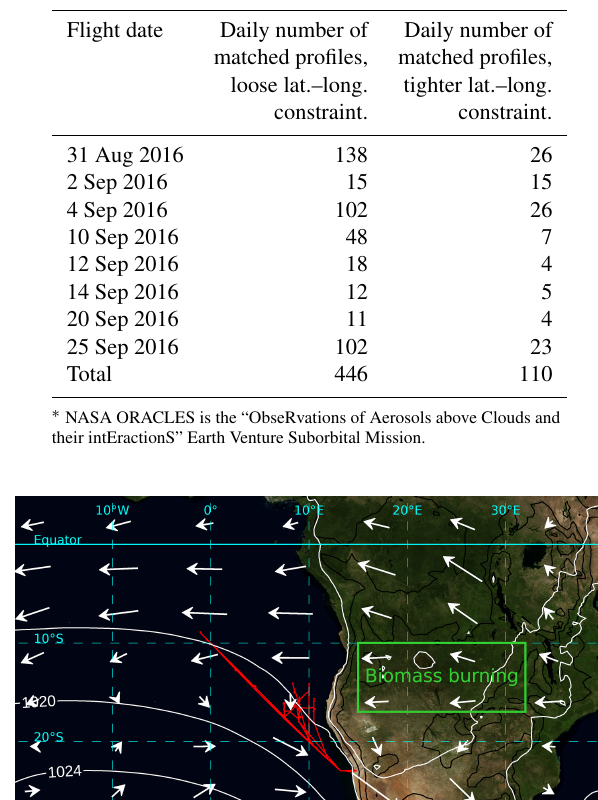
Table 1. Summary of matches of aircraft WISPER δ D measure- ments during NASA ORACLES ∗ with collocated AIRS observa- tions. The loose latitude–longitude constraint (second column) is that all AIRS geolocations within the same rectangle of maximum to minimum latitude and maximum to minimum longitude are se- lected for an aircraft vertical profile ( ∼ 100 to 300km in length). The tighter latitude–longitude constraint (third column) is to match only AIRS geolocations within 0.3 ◦ (30km) of the aircraft flight track.